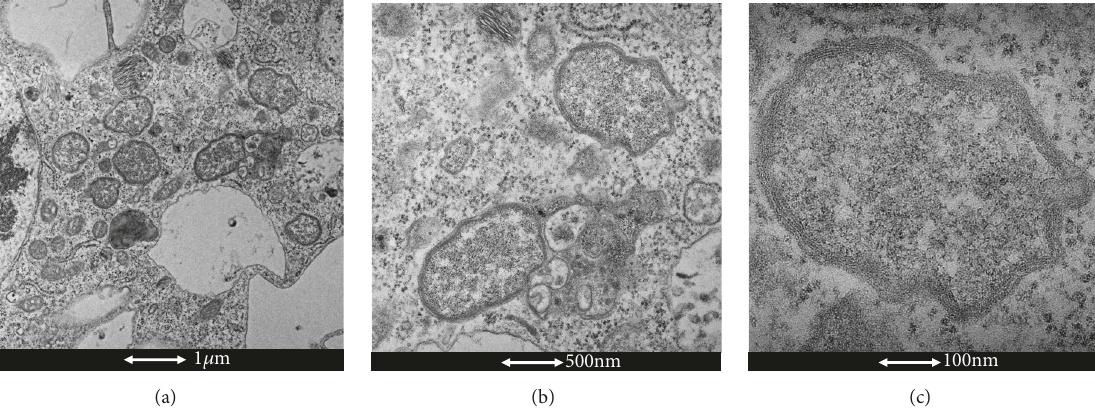
Figure 1: Electron microscopy of Wolbachia . ( a ) Wolbachia cocci (Scale bar: 1 𝜇 m). ( b ) Zoom of two Wolbachia cells (Scale bar: 500nm). ( c ) Zoom of a single Wolbachia cell (Scale bar: 100nm). (by El Hadji Amadou